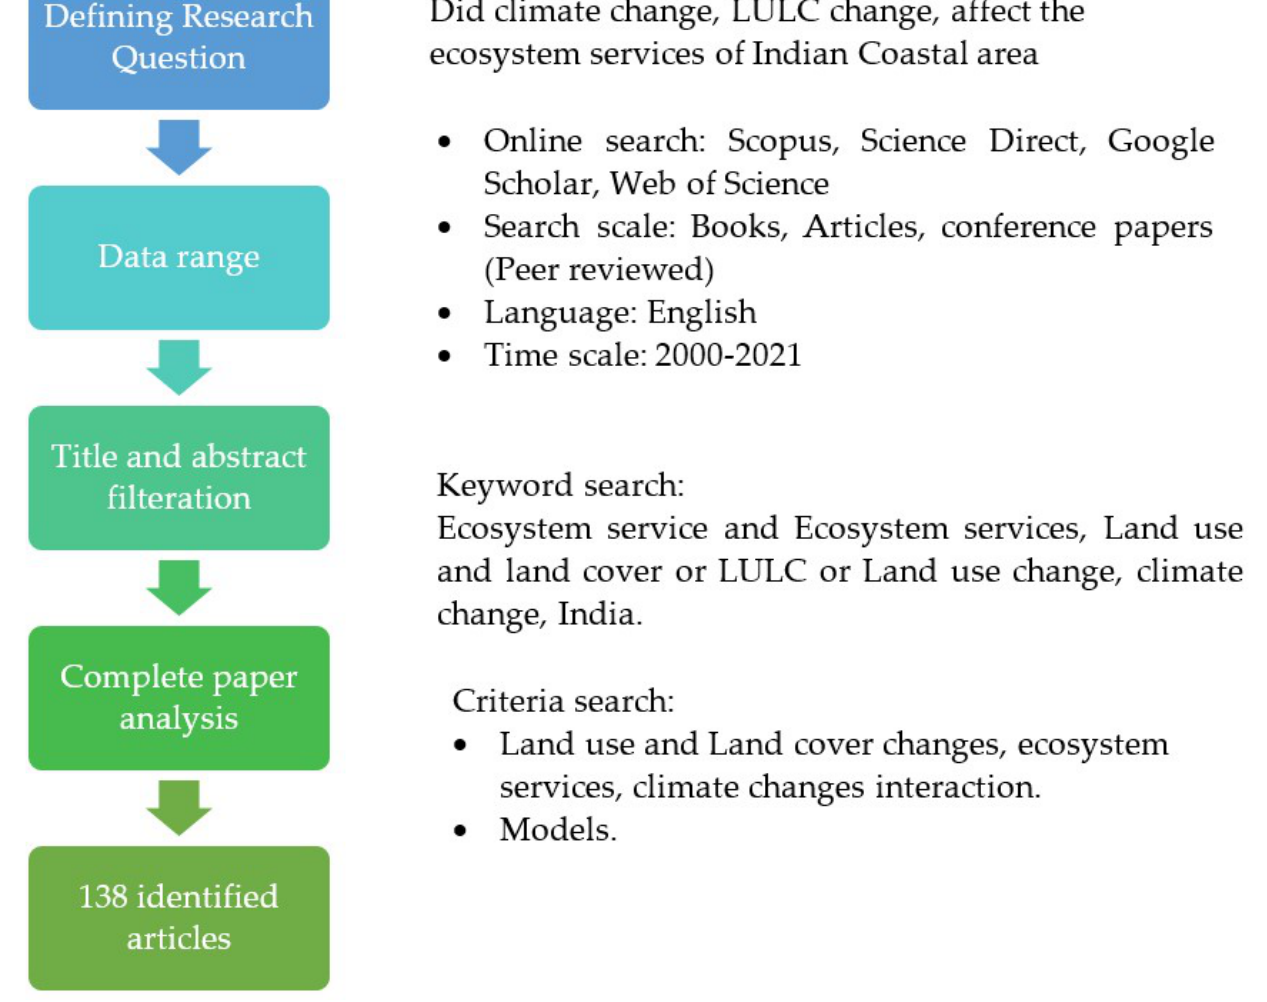
Figure 1. Showing the flow chart of the data analysis for ecosystem services.